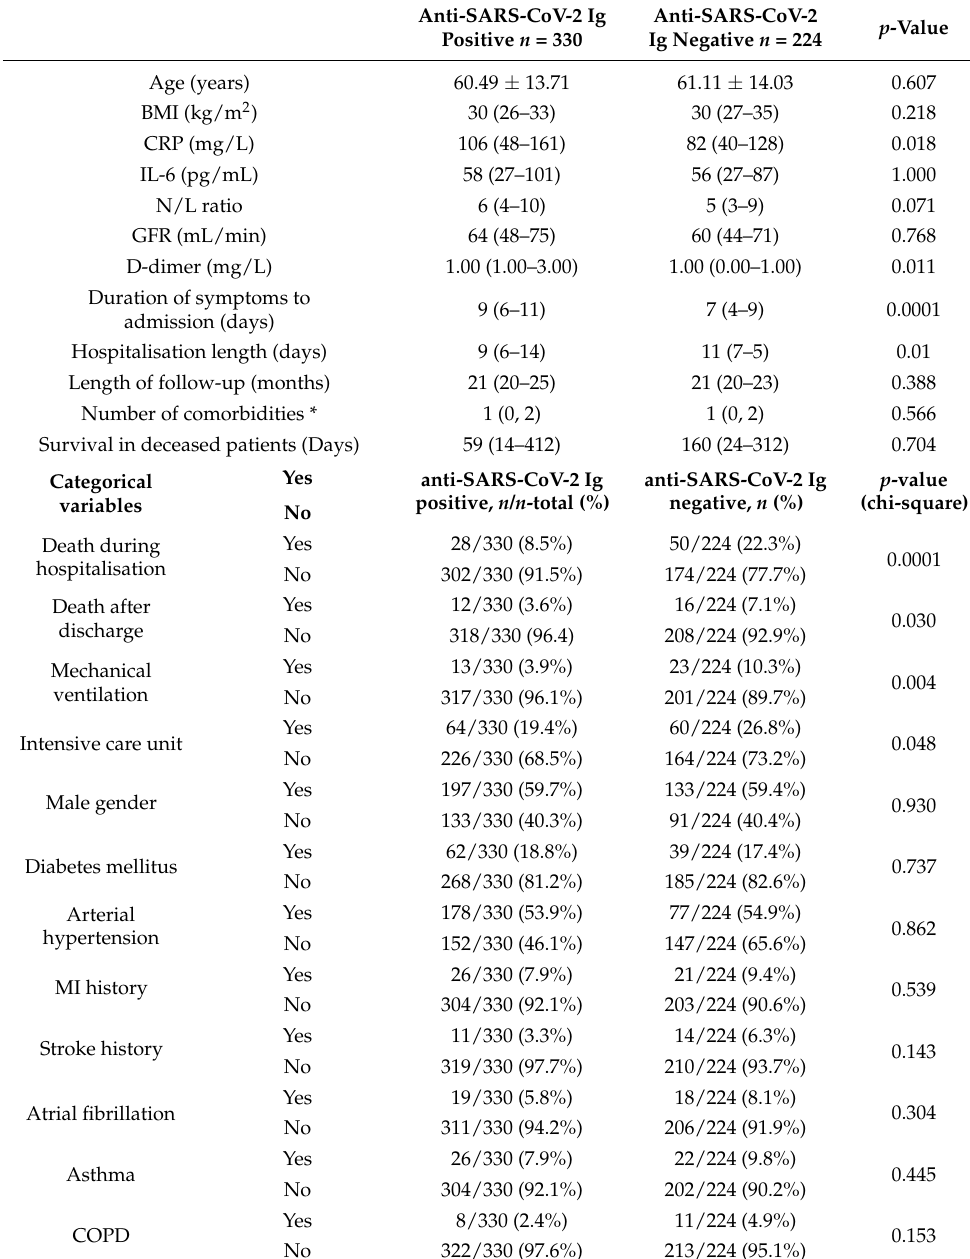
Table 1. Baseline characteristics of the cohort of patients with positive anti-S-SARS-CoV-2 im- munoglobulins and the cohort of patients with negative